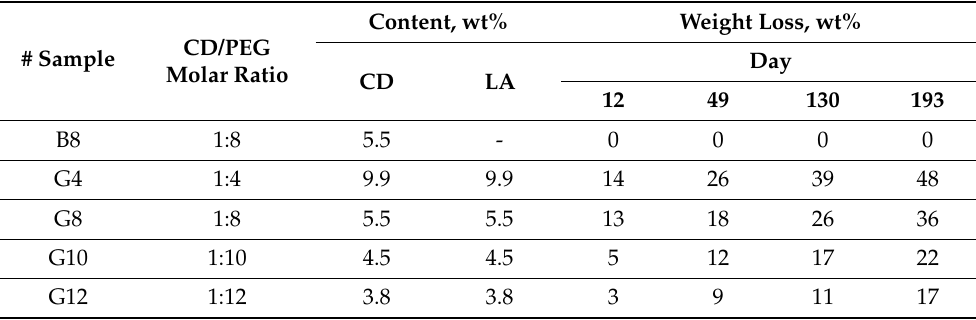
Table 4. Theoretical content of the hydrogels according to synthesis feed versus degradation weight